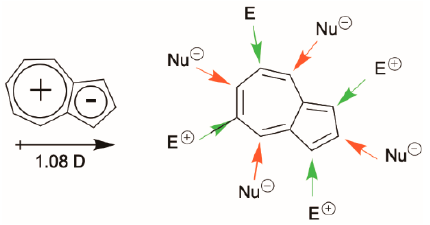
Figure 1. Polarized resonance structure of azulene with the dipole moment ( left ) and reactivity of each position of azulene ( right ). Adapted with permission from [33], Copyright 2021, American Chemical Society.